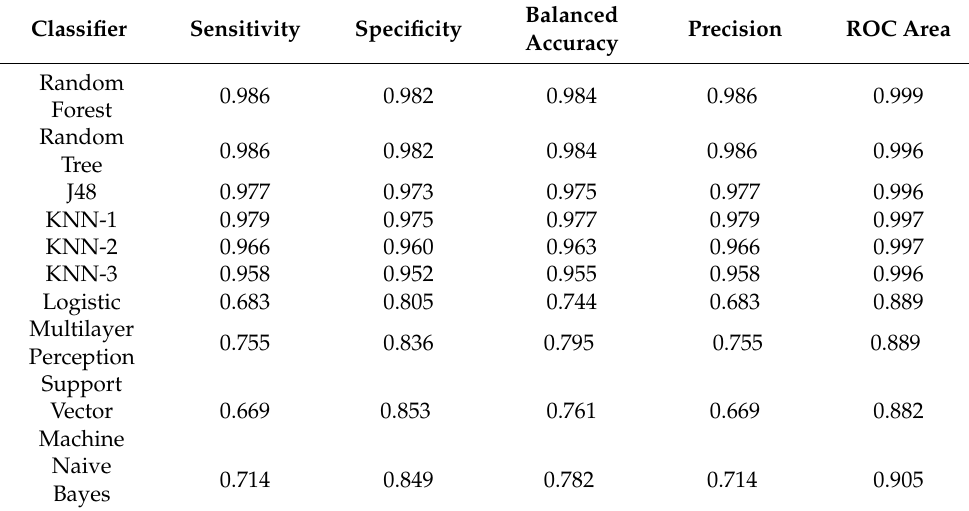
Table 1. Description of performance measures (sensitivity, specificity, balanced accuracy and preci- sion) in different